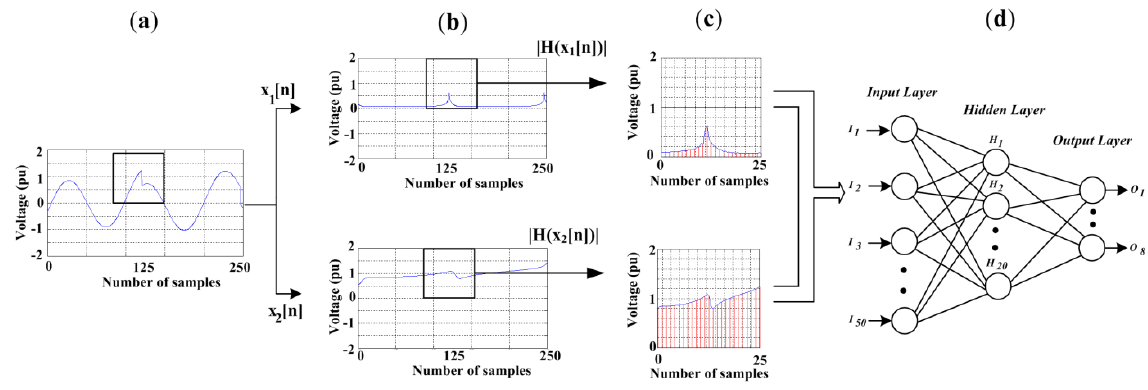
Figure 6. Procedure of classification. ( a ) Sinusoidal wave with spikes; ( b ) HT outputs; ( c ) Decimated HT outputs; ( d ) Proposed